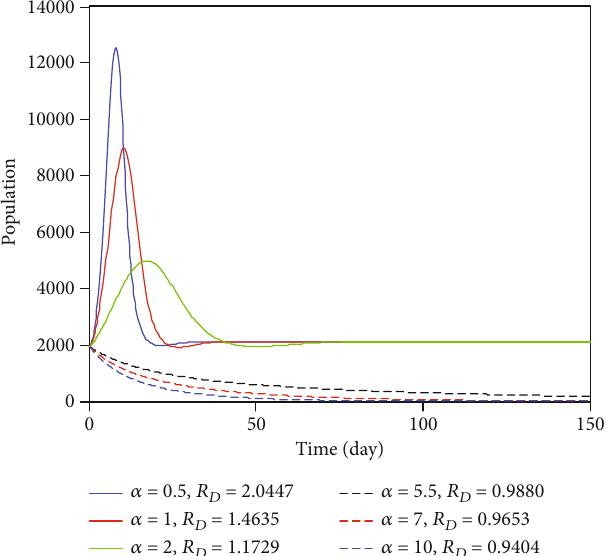
Figure 5: The dynamics of infectious population for κ = 1 with di ff erent values of α and other parameter values are given in Table